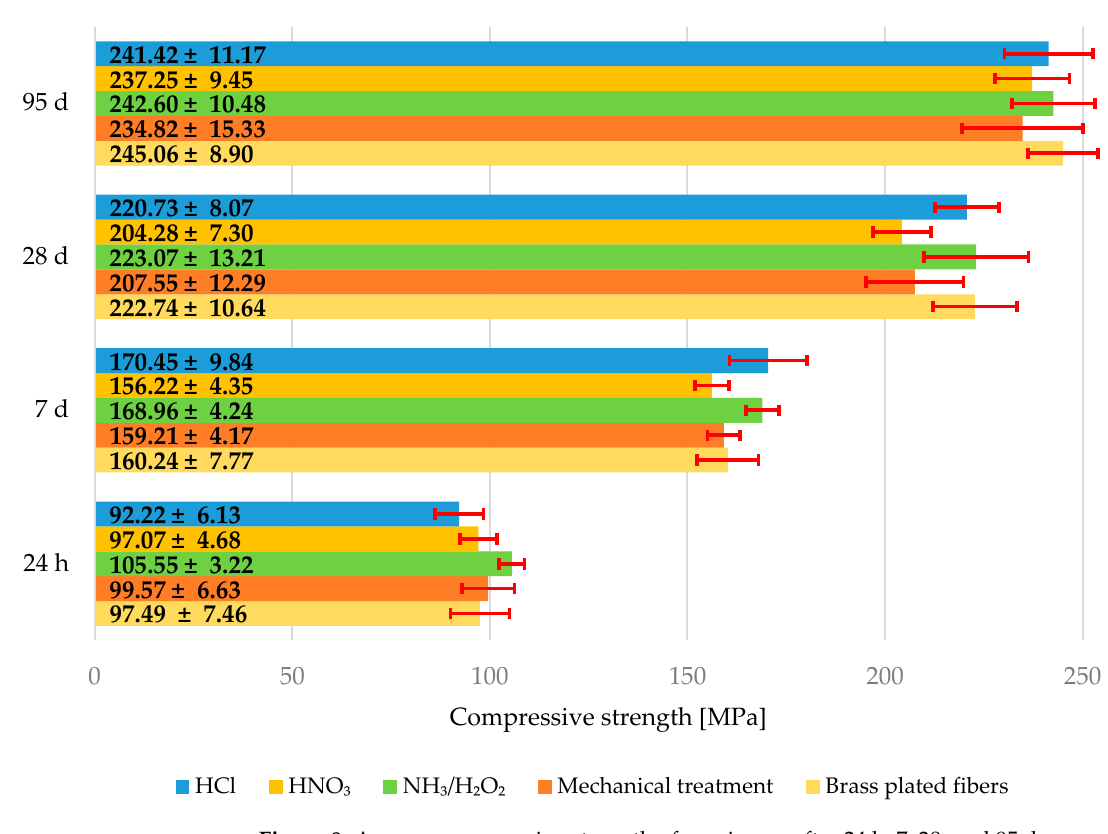
Figure 8. Average compressive strength of specimens after 24 h, 7, 28, and 95 days.